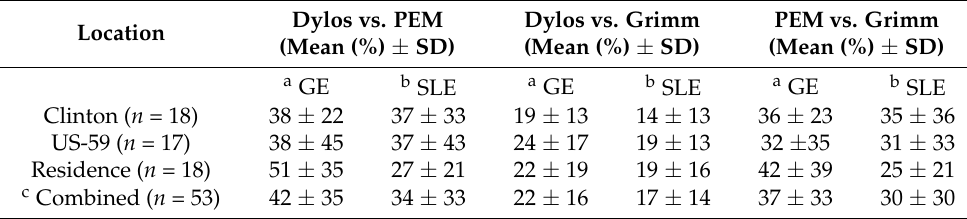
Table 3. Mean absolute relative error between Dylos and research grade instruments by location . Dylos vs. PEM Location (Mean (%) ± SD)